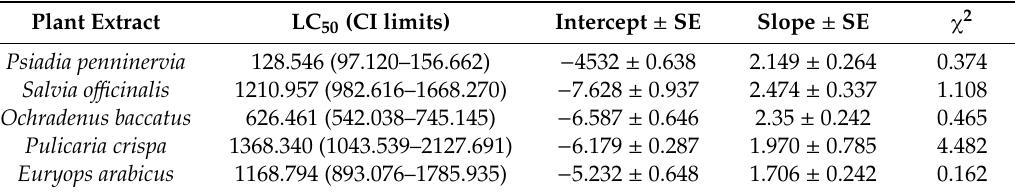
Table 3. Values of LC 50 ( µ g / mL) for extracts from five medicinal plant species against adults of Aphis craccivora .